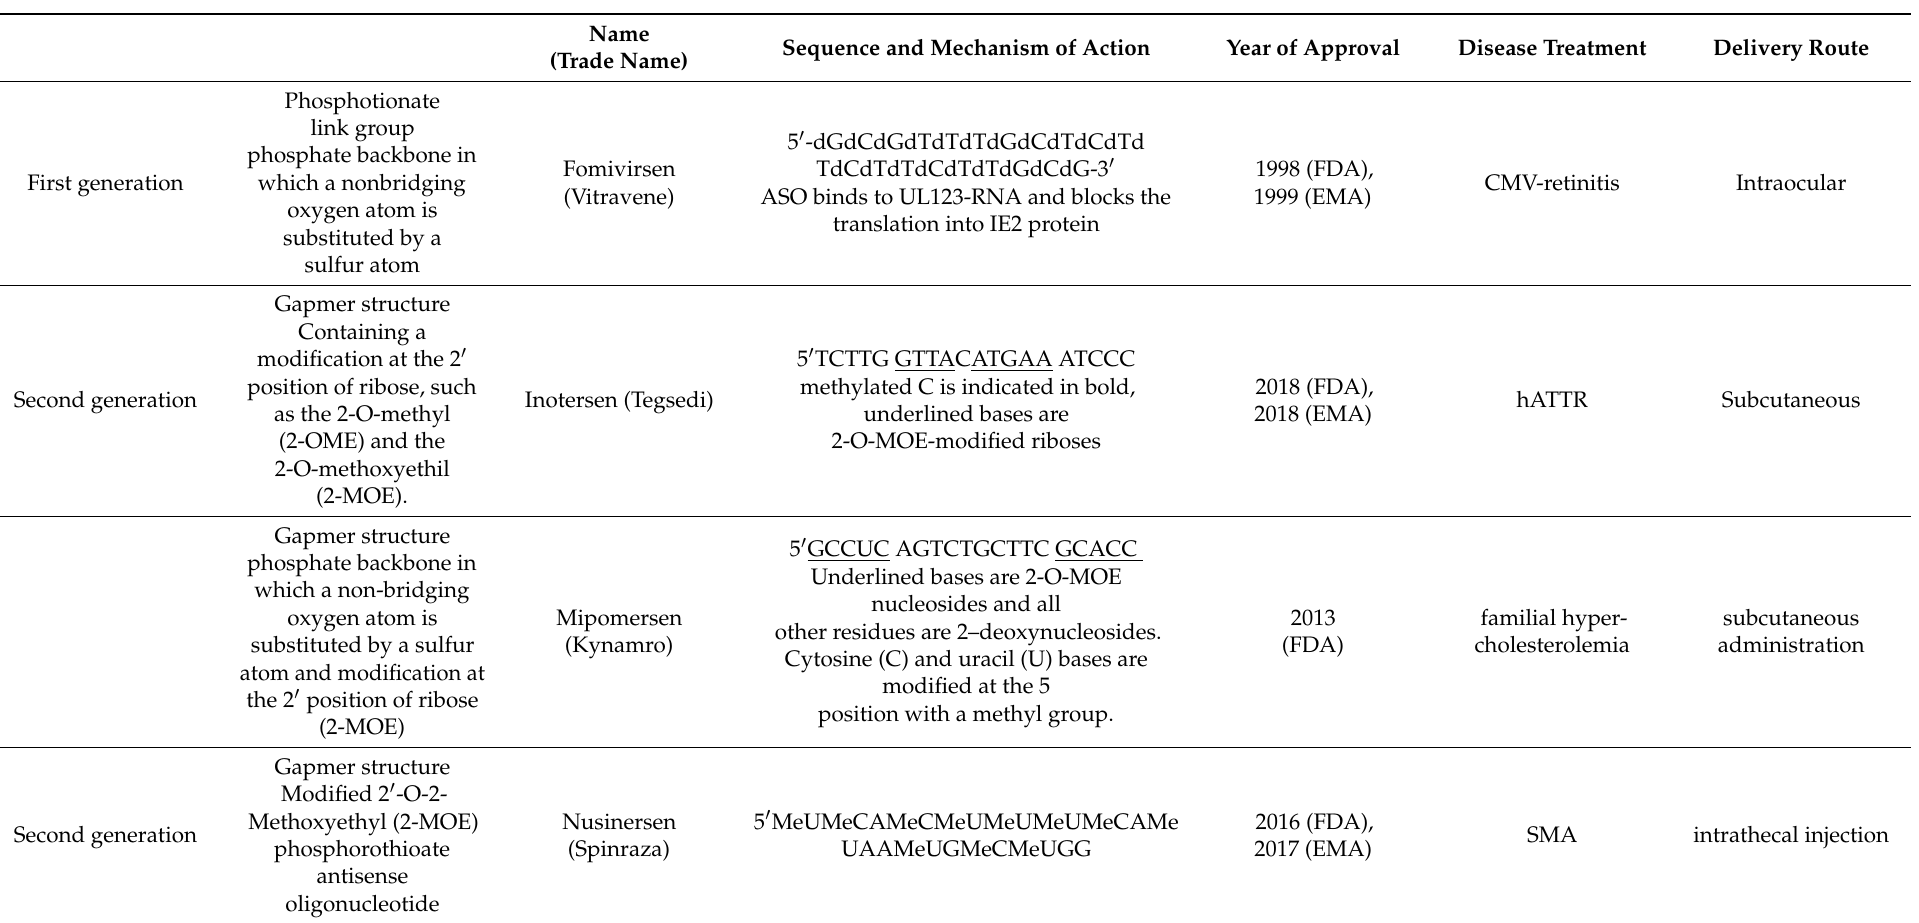
Table 1. List of main ASOs classified on the basis of their chemical modifications in first, second, and third